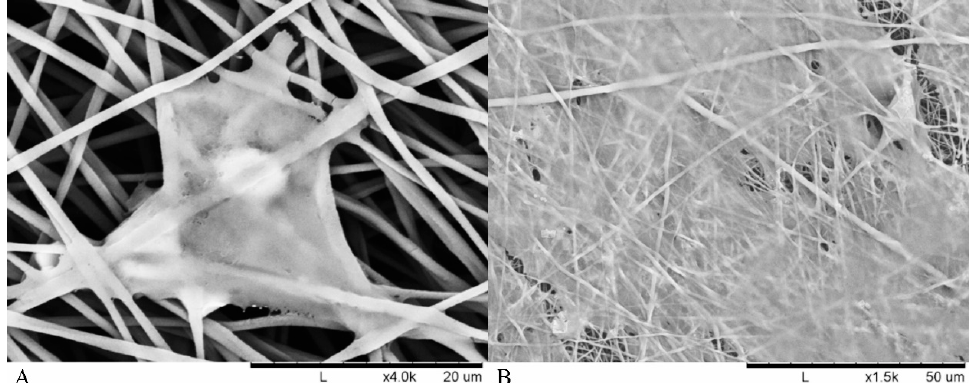
Figure 6. SEM images of adhered RAOSMC in polymer fibres ( A ) 40 µ m image at 3 days ( B ) 120 µ m image at 14 days.